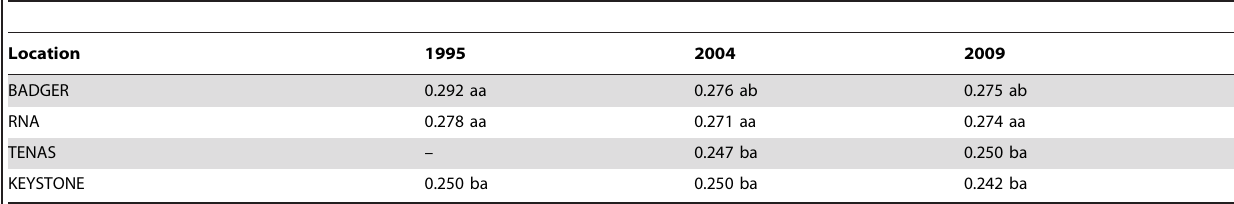
Table 3. Expected heterozygosity (H e ) under Hardy-Weinberg genotypic proportions for ex situ samples collected in 1995, recollected in 2004, and in situ populations sampled in 2009.